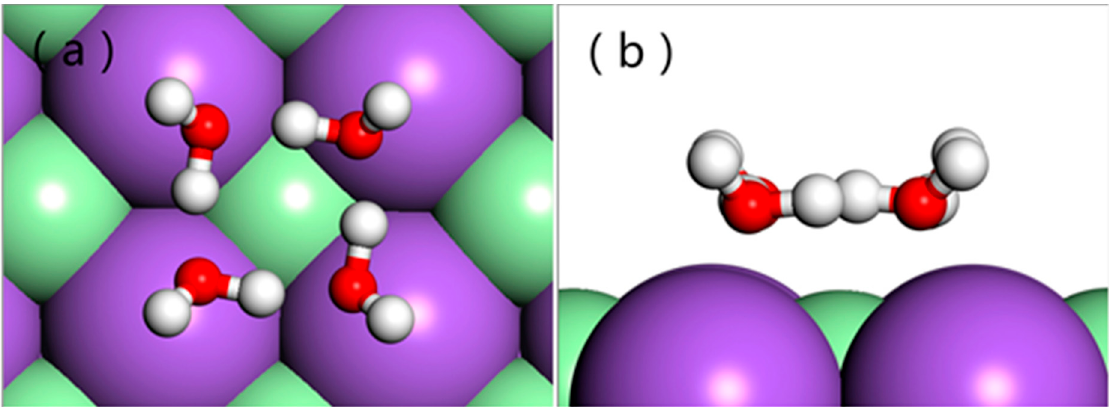
Figure 5. Optimized geometry structure of the water tetramer on the NaCl(001) surface. Image ( a ) is the top view and ( b ) is the side view.